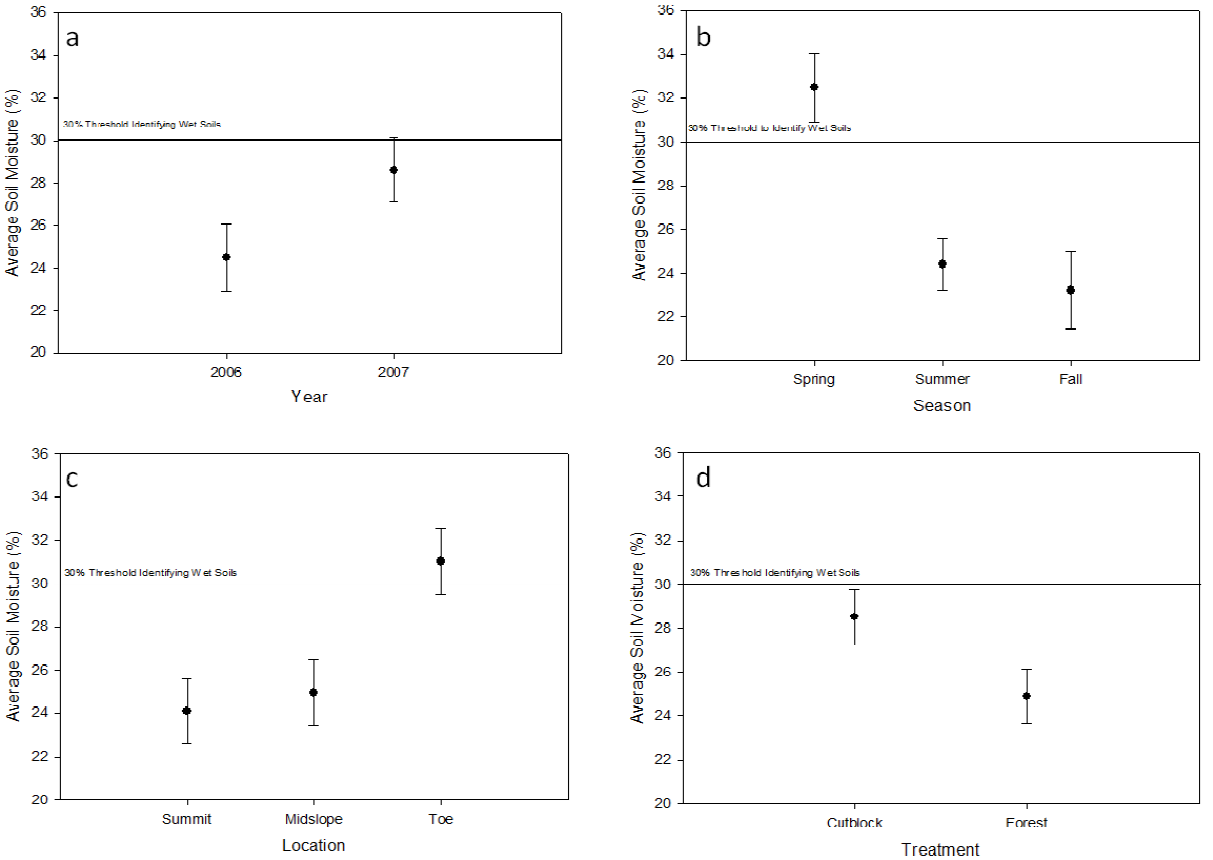
Figure 4. Average soil moisture conditions across ( a ) years; ( b ) seasons; ( c ) locations; and ( d ) treatments (Least squares means and 95% CI, n = 96). Line at 30% soil moistures identifies wet soil